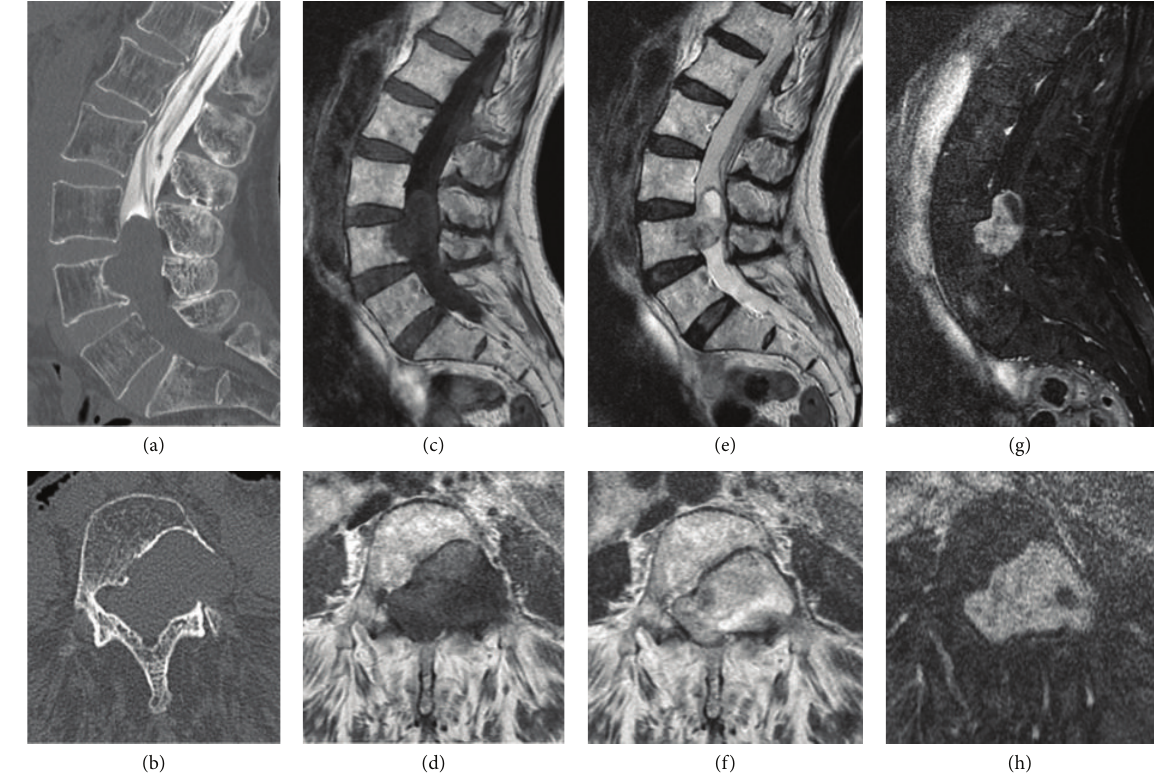
Figure 1: CT after myelography showing bone scalloping of the L4 vertebra body and left pedicle, and central spinal canal stenosis at L3 and L4 ((a) and (b)). MRI on the T1- ((c) and (d)) and T2-weighted images ((e) and (f)) before surgery. T1-weighted MRI scan after gadolinium administration showed enhancement of the spinal tumor ((g) and (h)).